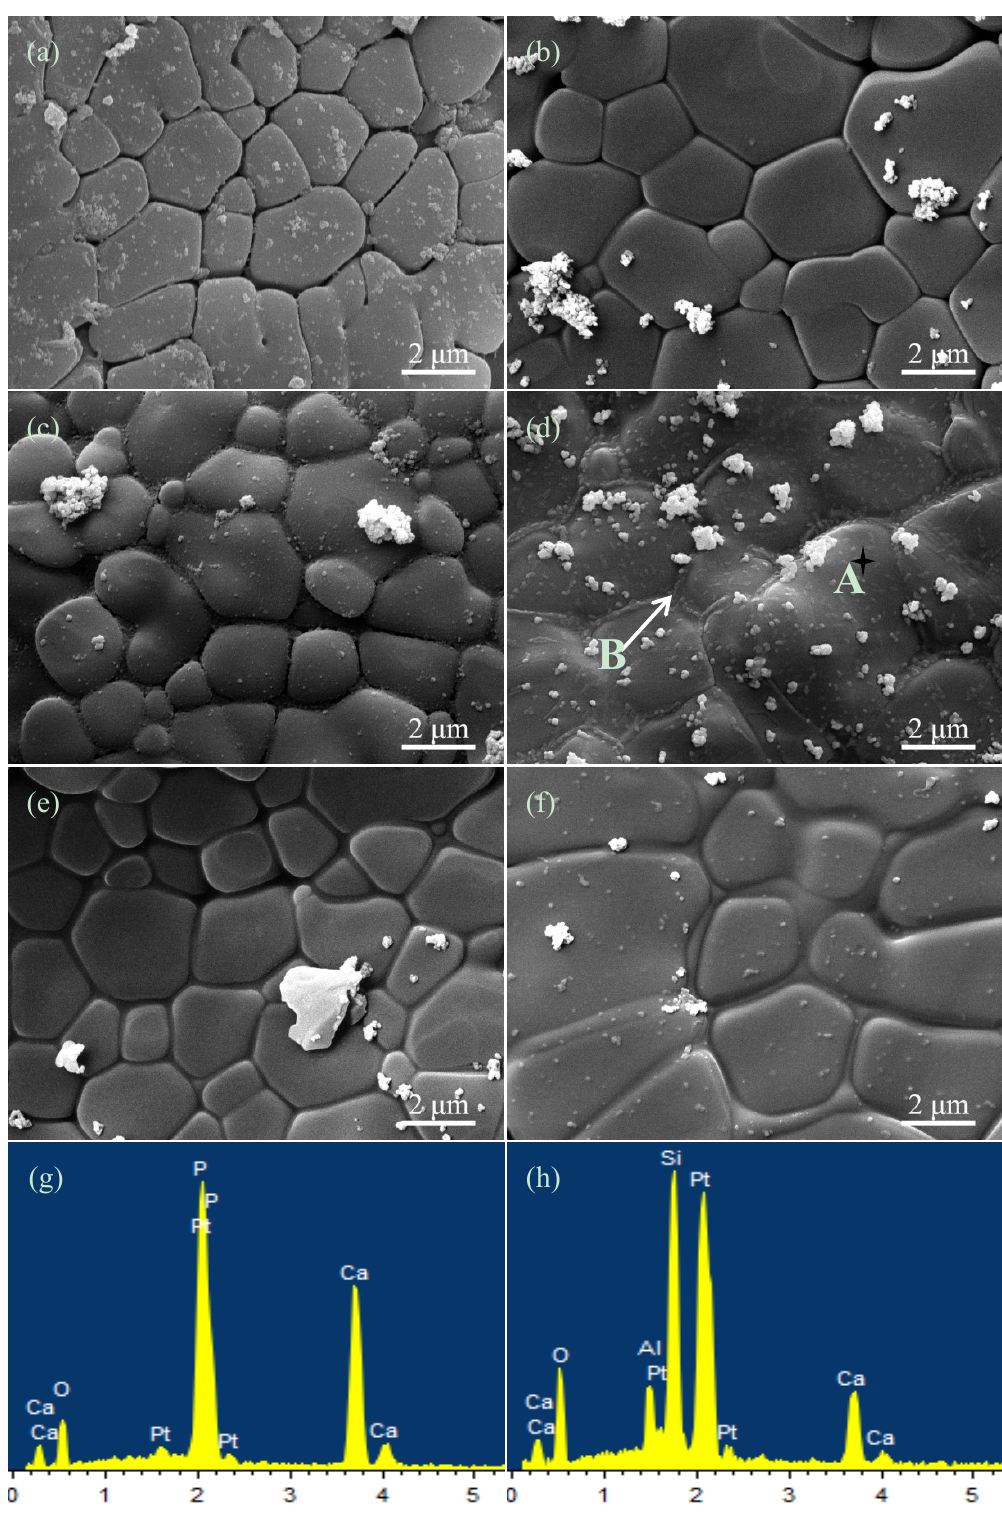
Figure 2. The morphologies of the HAp ceramics without or with CAS: ( a ) 0; ( b ) 1; ( c ) 2; ( d ) 3; ( e ) 4; and ( f ) 5 wt% and energy dispersive spectroscopy (EDS) spectrums: ( g ) A; ( h )